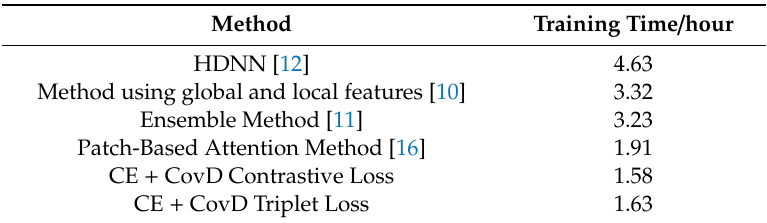
Table 3. Training time comparison of our method and the other methods.